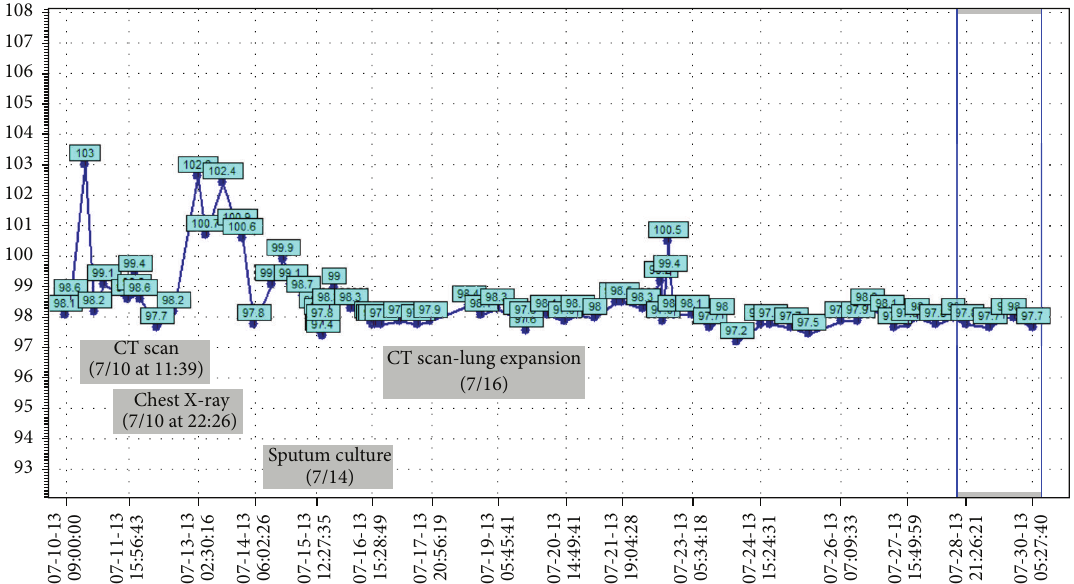
Figure 5: Sputum culture showed E. coli just after a fever spike, afterwhich the liver mass was found to have expanded into the